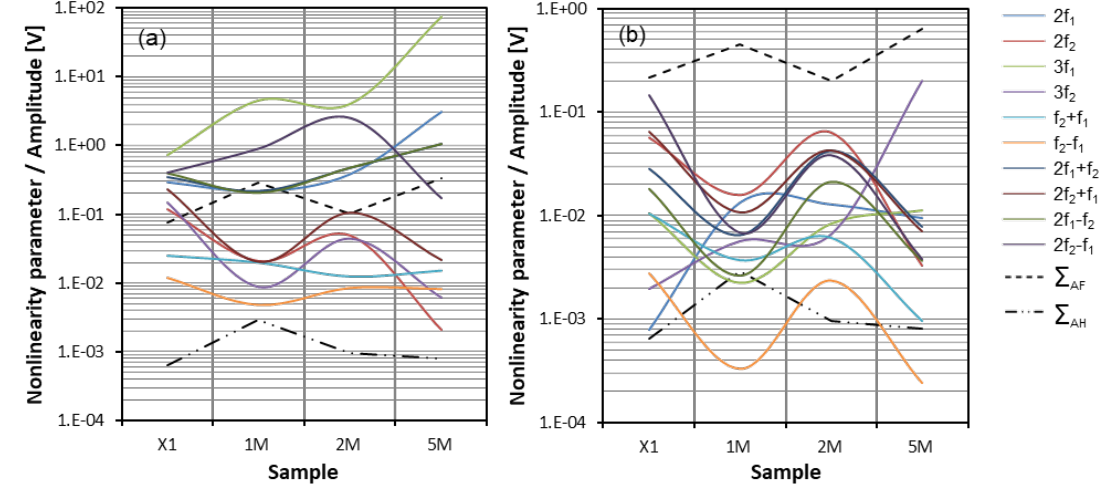
Figure 15. Nonlinearity parameter: ( a ) f 1 = 3 MHz, f 2 = 5 MHz, α = 60°; ( b ) f 1 = 4 MHz, f 2 = 5 MHz, α = 60°.